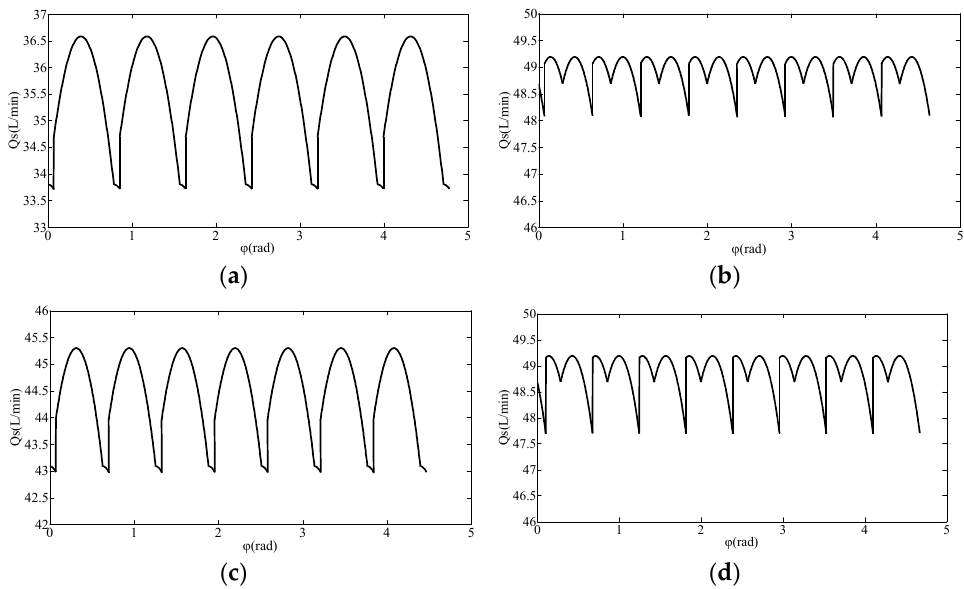
Figure 10. Actual output flow rate of piston pumps with 8~11 pistons for Δφ/2 = φ 0 = 2°. ( a ) output